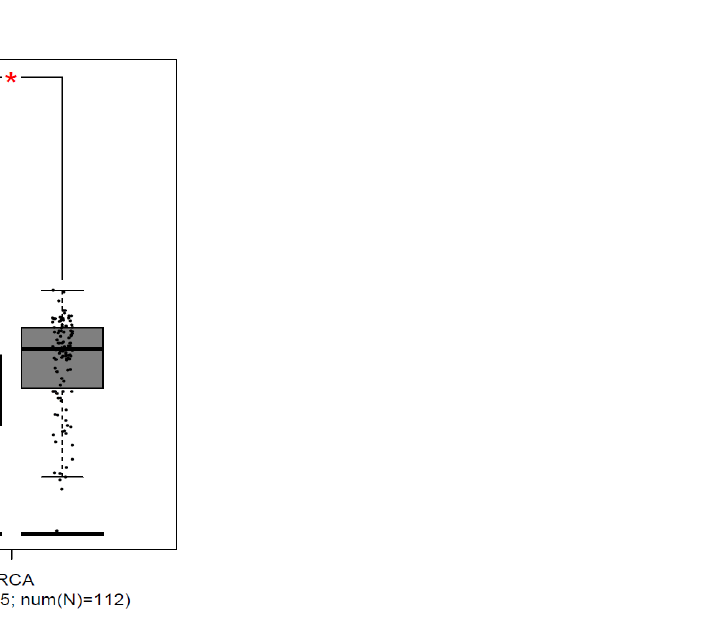
Figure 2. Expression of FGFR2 in breast cancer tissues and normal tissues. Each bar indicates the average level of expression of FGFR2. Error bars are the standard deviation of the mean value. Data from the GEPIA database were extracted (http://gepia.cancer-pku.cn/, accessed on 20 November, 2022). * statistical significance ( p < 0.01).